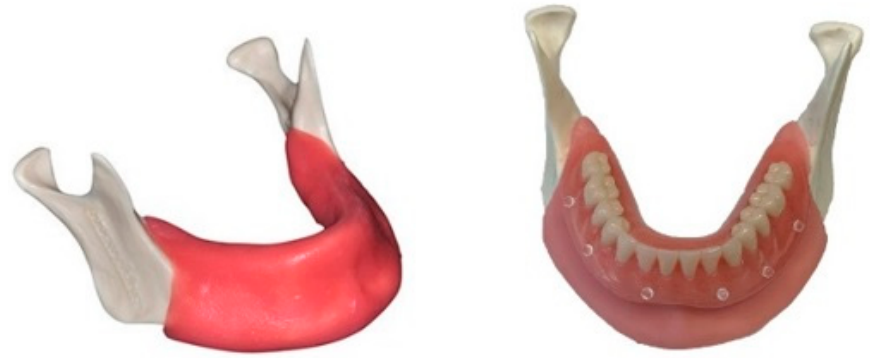
Figure 1. Cast with the scan-prosthesis.